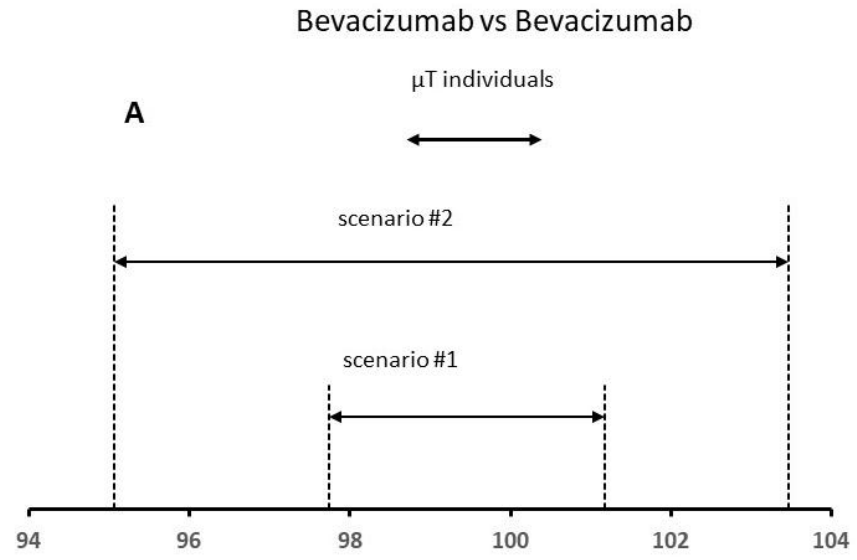
Table 2. Values of the mean and standard deviation for the reference product obtained by the simulation data set under different